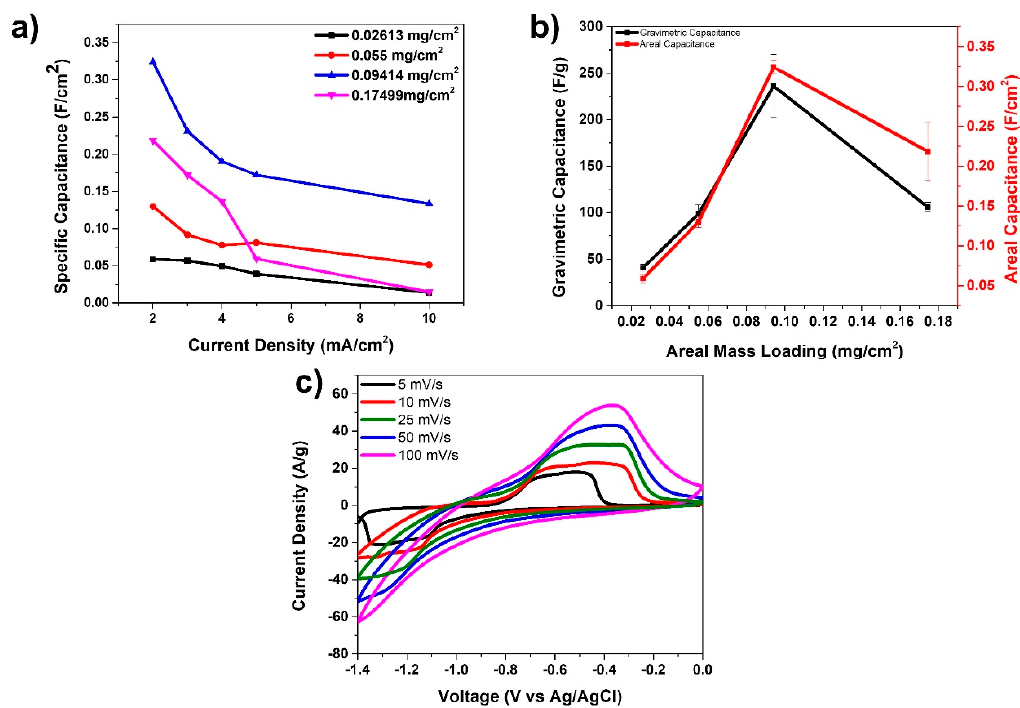
Figure 5. ( a ) Specific capacitance vs. current density for anode materials; ( b ) gravimetric capacitance and areal capacitance of various anodes at 2 A/g and 2 mA/cm 2 ; and ( c ) CV curves at various scan rates for 0.094 mg/cm 2 mass loading anode.